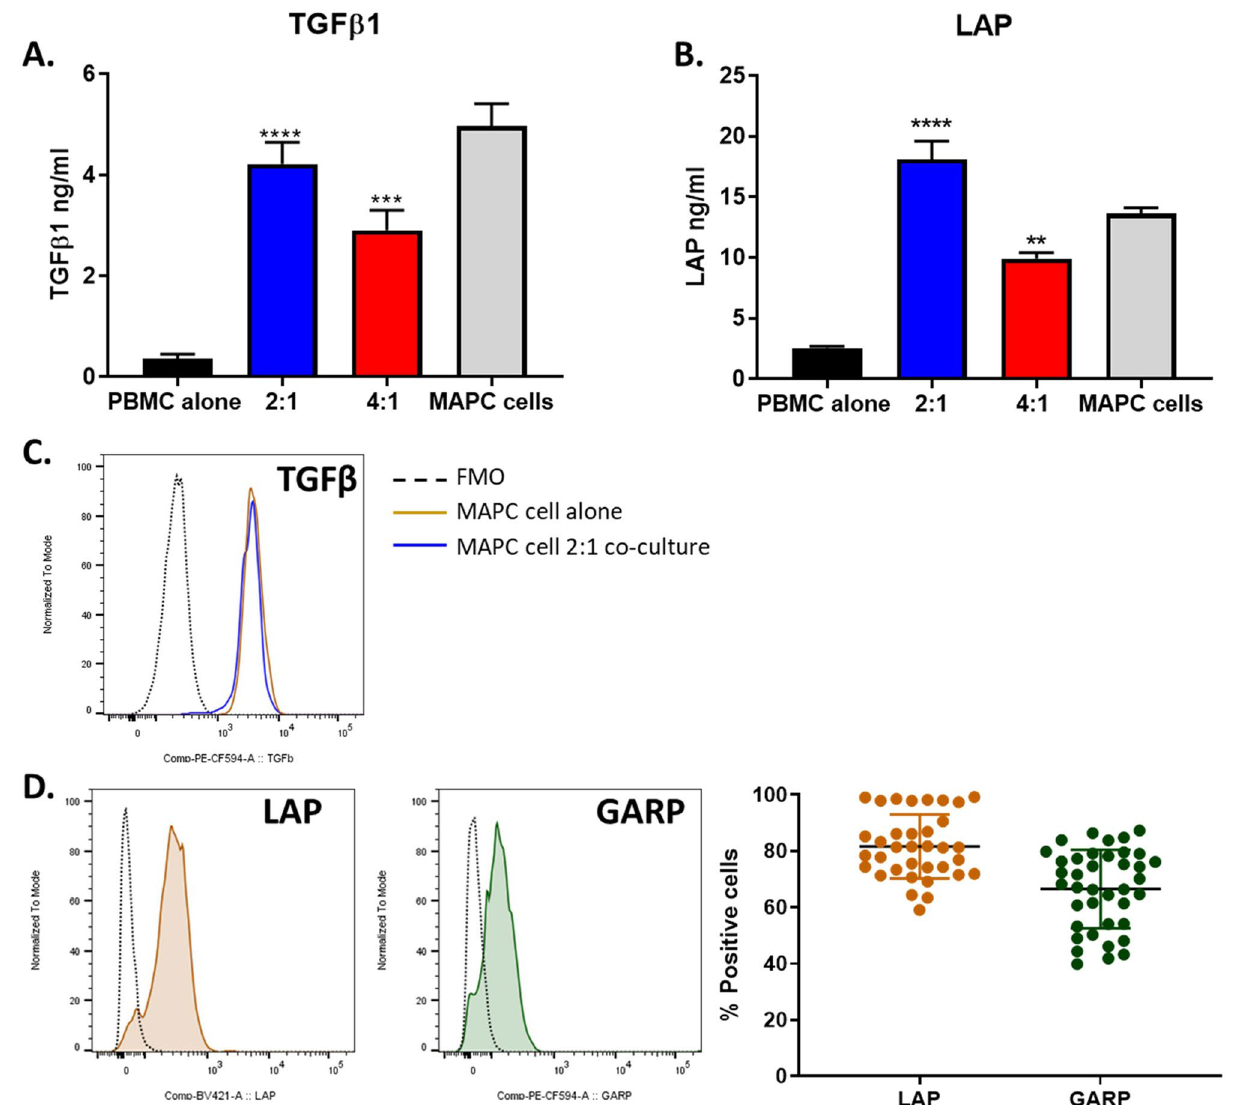
Figure 4. MAPC cells secrete high levels of TGFβ1. ( A ) TGFβ1 and ( B ) LAP concentrations in supernatants from 7-day cultures of PBMC alone (black), 2:1 (blue) and 4:1 (red) PBMC:MAPC cells, and MAPC cells alone (gray) measured by ELISA. MAPC cells were plated alone at 2:1 equivalent cell number. ( C ) Intracellular TGFβ in MAPC cells cultured alone (gold) or with PBMCs at 2:1 PBMC:MAPC cell ratio (blue). FMO represented as dotted line. ( D ) LAP (blue) and GARP (red) surface expression on MAPC cells determined by flow cytometry. FMO shown as dotted black line. Graph showing quantification of LAP (gold) and GARP (green) surface expression on MAPC cells. Data represent mean ± SD from pooled samples of five independent experiments using three different MAPC cell donors. Statistical analysis was performed using One-way ANOVA with a Tukey’s multiple comparisons test reference to the control PBMC alone (****p < 0.0001, ***p < 0.001, and **p <